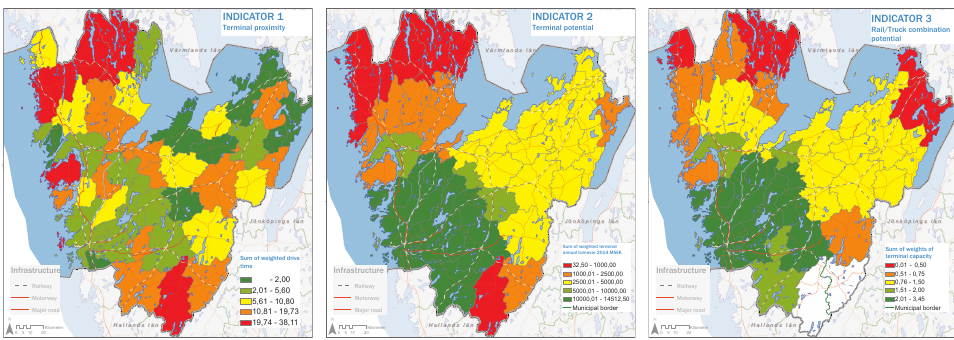
Figure 9: Illustration of the three municipality-based indicators. Left to right: terminal proximity, terminal potential, and rail/truck combination